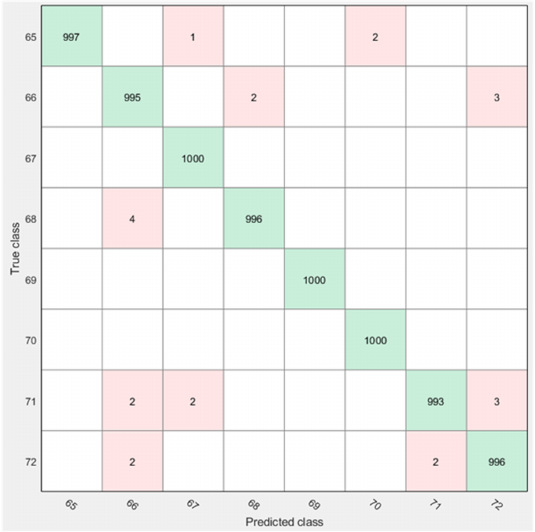
Figure 8. Confusion Matrix of Cubic SVM on GA-optimized features.